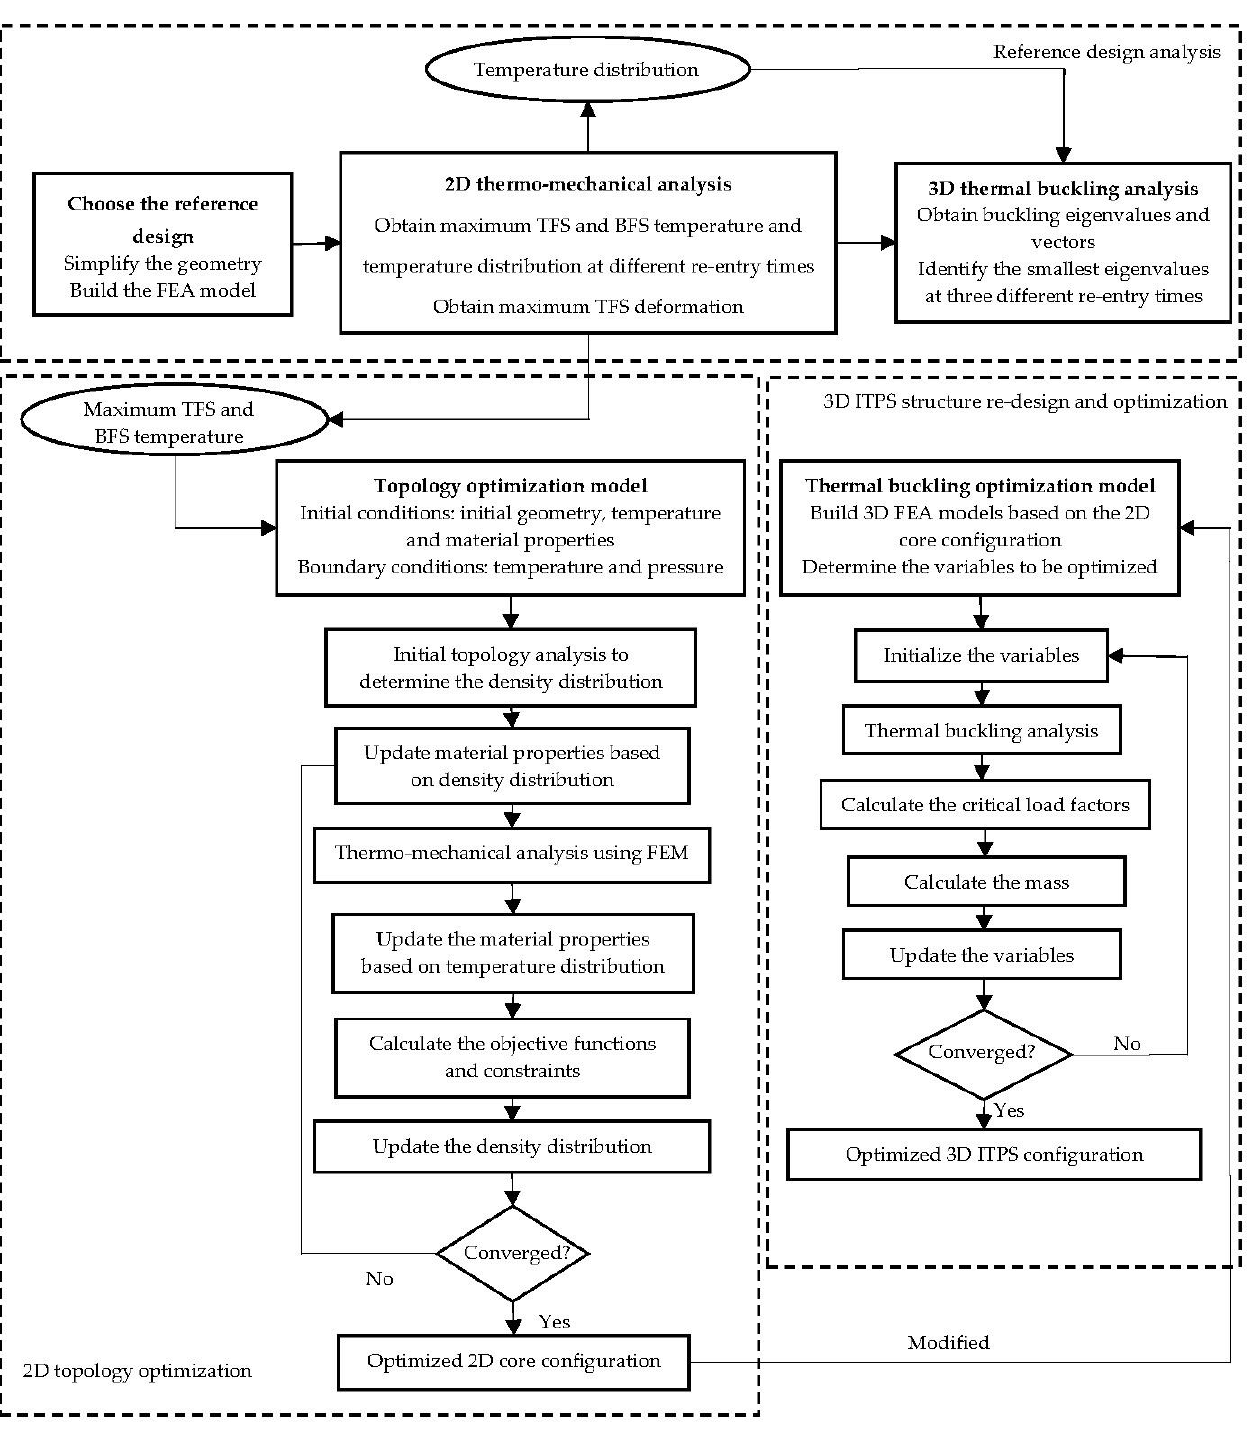
Figure 8. Flowchart of the optimization procedure of ITPS.